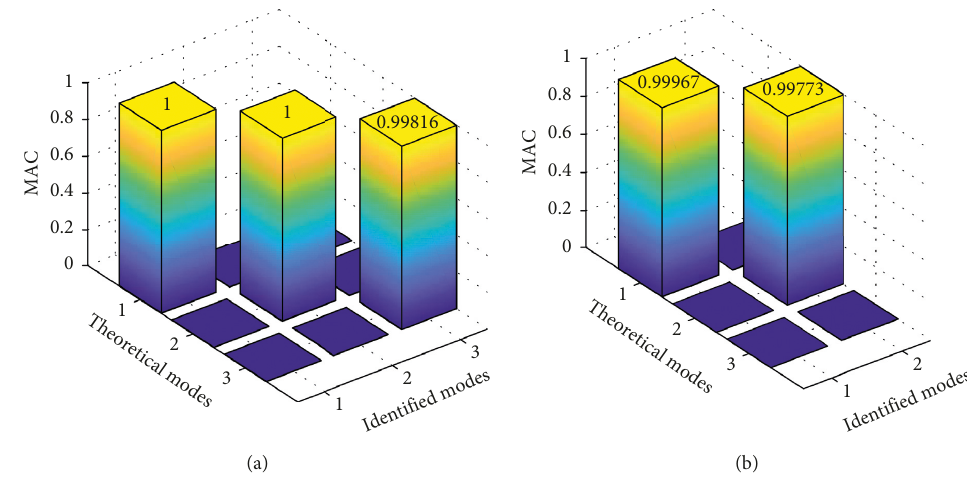
Figure 11: MAC of ACS-SSI results. (a) ACS-SSI (SNR